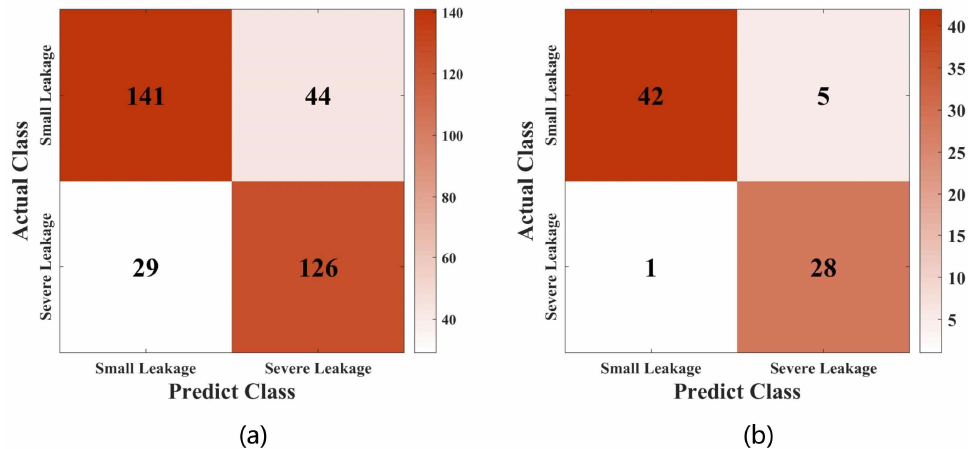
Figure 9. Leakage degree prediction results: ( a ) the steady-state time series data set; ( b ) the water- consumption time series data set.